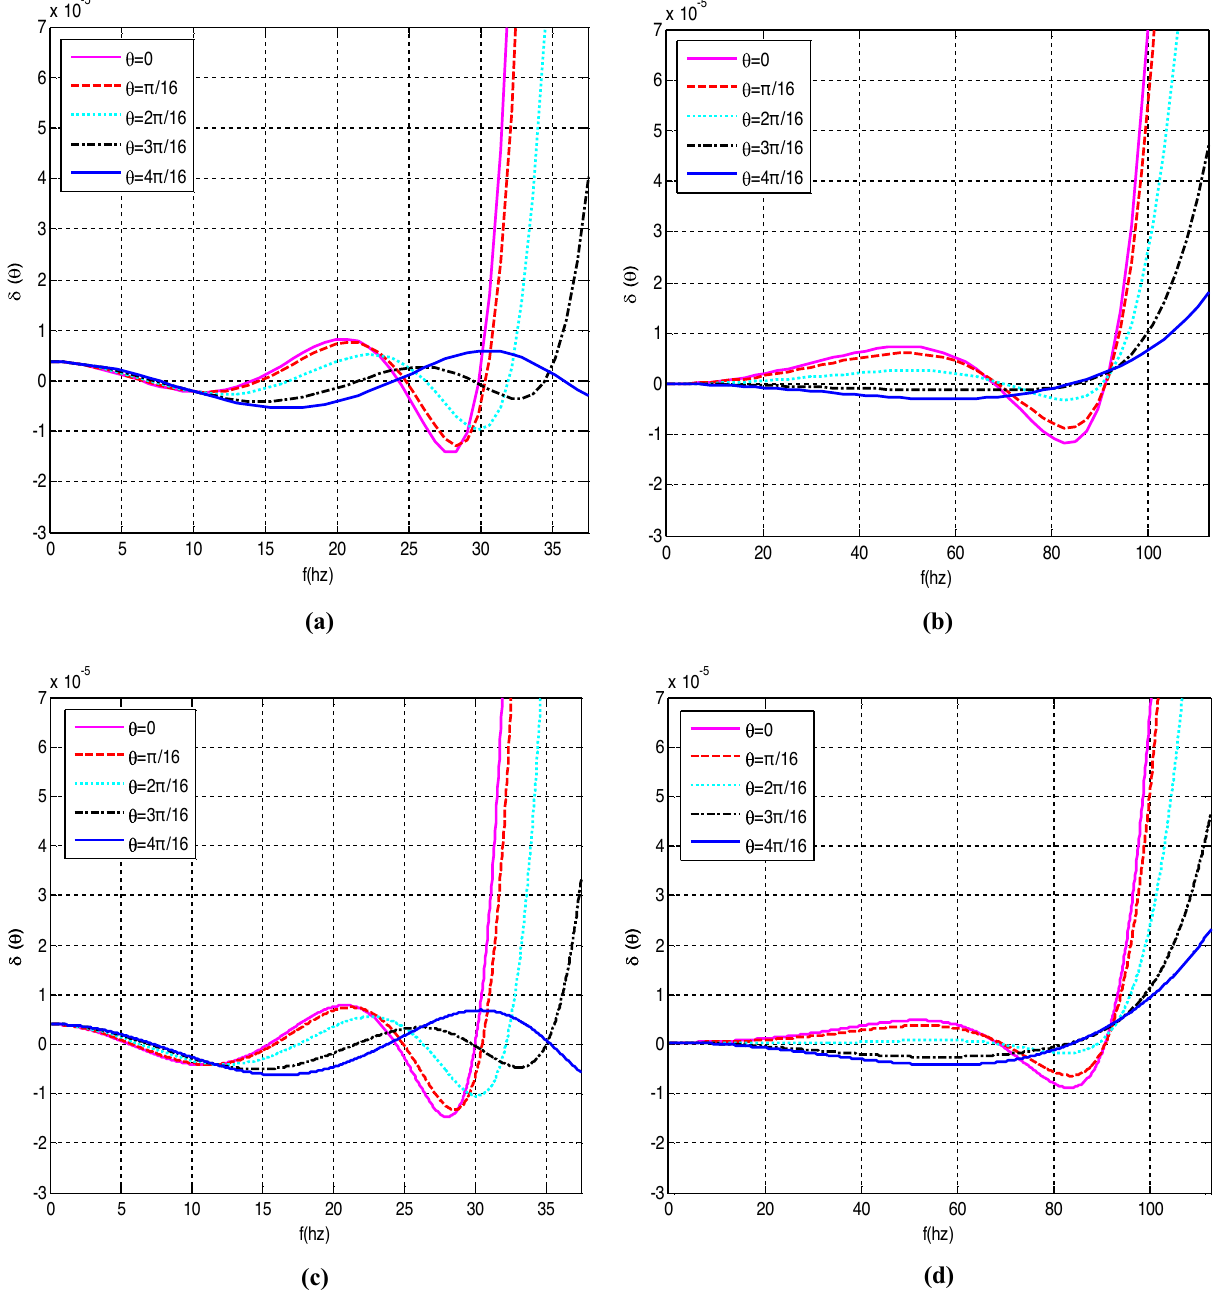
Figure 1. Dispersion error curves for the different implicit SGFD schemes. The time step is 2.5 ms and the spatial grid interval is 20 m. ( a ) The implicit SGFD scheme with v = 1500 m/s; ( b ) the implicit SGFD scheme with v = 4500 m/s; ( c ) the HEI-SGFD scheme with v = 4500 m/s; ( d ) the HEI-SGFD scheme with v = 4500 m/s.